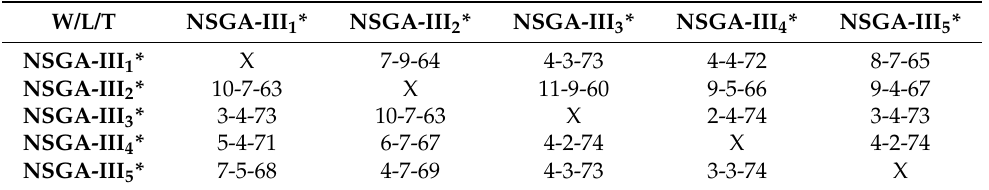
Table 1. Summary of the experimental results demonstrating the robustness of the NSGA-III* to the parameter values in the ensemble